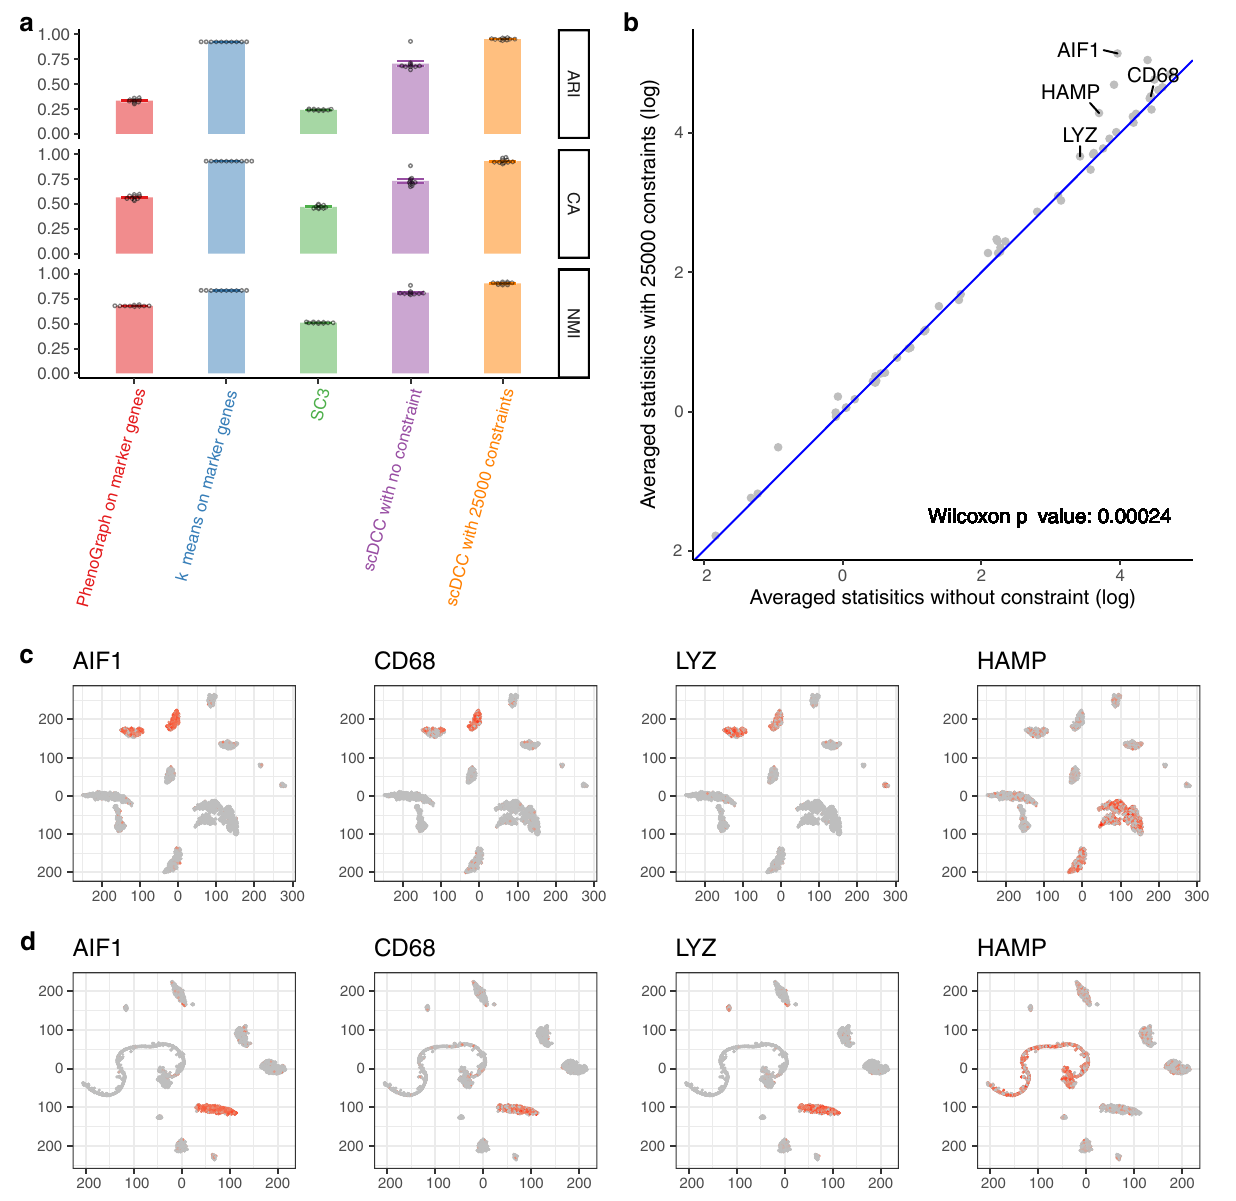
Fig. 6 Clustering analysis on the human liver cells with marker gene-based constraints. a Clustering performances of PhenoGraph and k-means on ZIFA representations of marker genes, SC3, and scDCC (with and without constraints) on mRNAs of the human liver dataset measured by NMI, CA, and ARI. All experiments are repeated ten times (one dot represents one experiment), and the means and standard errors are displayed. Constraints were constructed by marker genes. b Average (with constraints comparing to without constraints) of speci fi city scores of 55 marker genes. One-sided Wilcoxon test p -value is also displayed (with constraints vs. without constraints). c Marker gene expression (log normalized counts) for each cell marked on the t-SNE plot based on latent representations of scDCC without any constraint. d Marker gene expression (log normalized counts) for each cell marked on the t-SNE plot based on latent representations of scDCC with 25,000 pairwise constraints. c , d t-SNE plots calculated from the bottleneck features of scDCC with and without constraints, respectively. Colors represent the relative expression levels; gray and red represent low and high expression levels, respectively. Axes are arbitrary